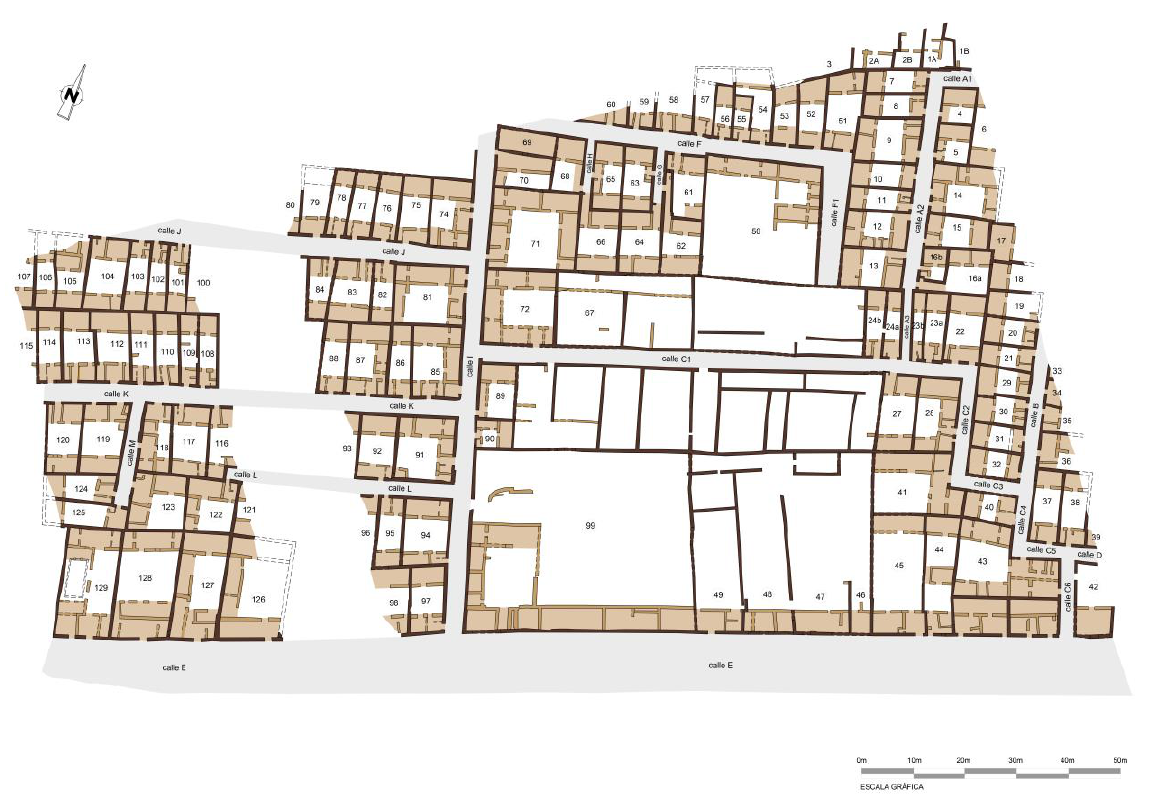
Figure 2. Huerta de Santa Isabel, C ó rdoba. Plan of the buildings identified in the caliphate-period arrabal